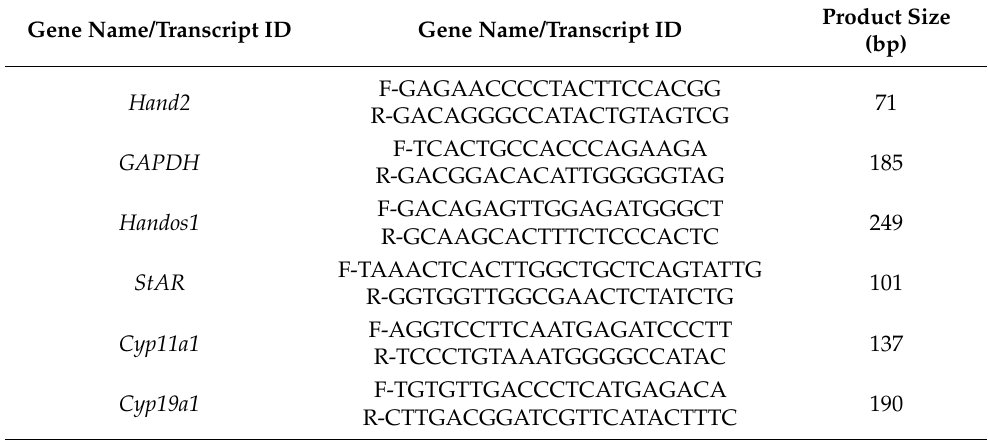
Table 1. Primer sequence for